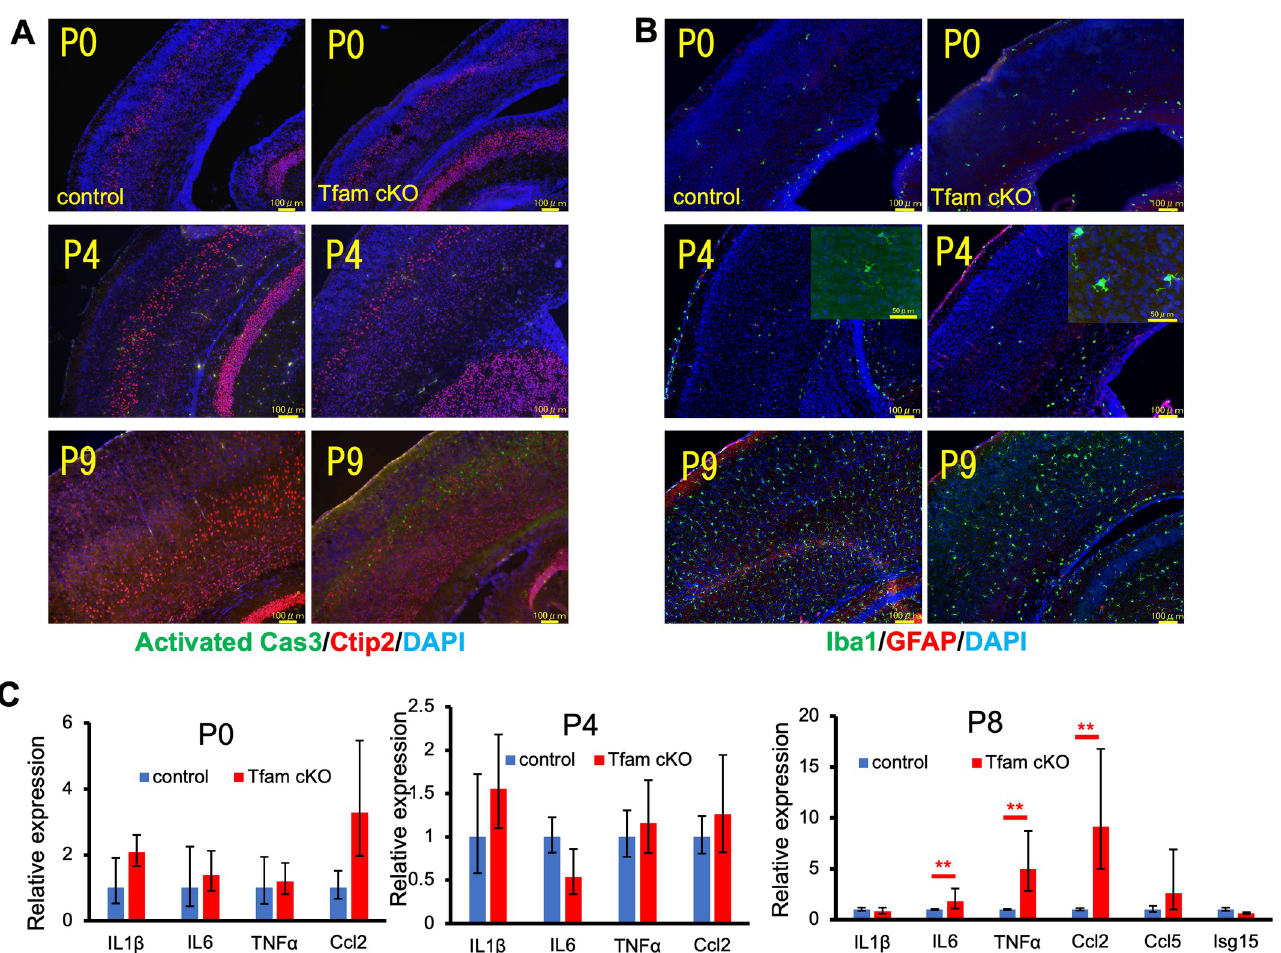
Fig 5. Apoptotic cell death and microglial activation in Tfam cKO brains. (A) Representative images of immunostaining with antibodies against activated caspase 3 and Ctip2 with DAPI nuclear staining of brains at P0, P4, and P9. Activated caspase 3-positive apoptotic cells can be detected in layer V neurons in Tfam cKO brains at P9. Scale bars, 100 μ m. (B) Representative images of immunostaining with antibodies against Iba1 and GFAP with DAPI nuclear staining of brains at P0, P4, and P9. Iba1-positive activated microglia are detected in Tfam cKO brains at P4. Scale bars, 100 μ m. (C) The expression of inflammatory genes by qRT-PCR. The expression levels of some inflammatory genes in Tfam cKO brains at P8 were significantly upregulated compared with those in control brains. Graph shows means ± SD. n = 3 mice per group. �� P < 0.01.